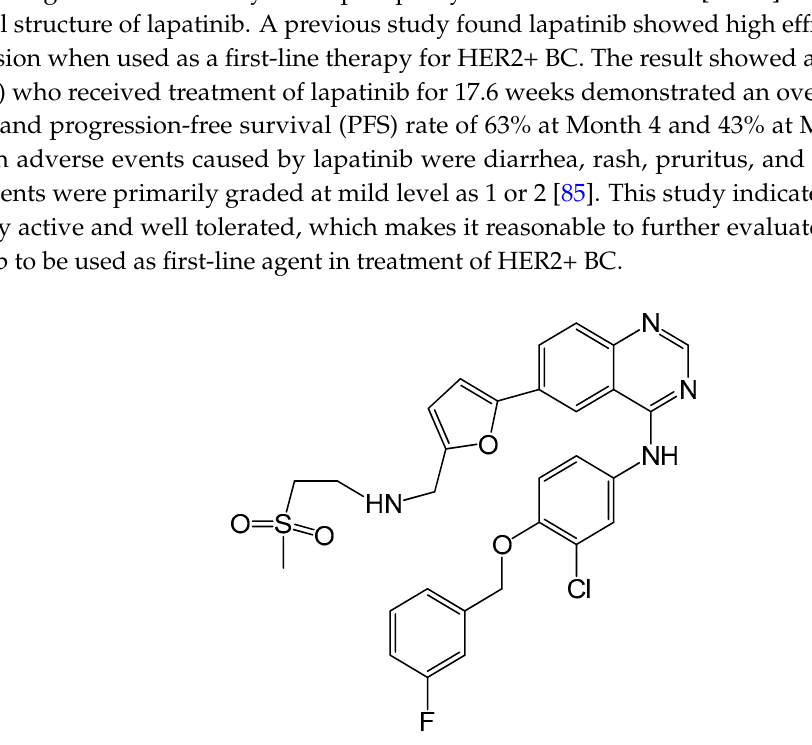
Figure 6. Chemical structure of lapatinib, with the chemical formula C 29 H 26 ClFN 4 O 4 S and a molecular weight of 581.0575 g/mol.